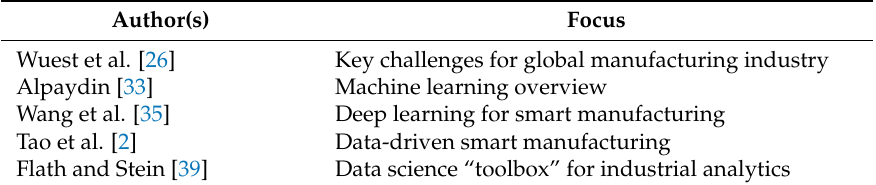
Table 2. Summary—big data for general industrial